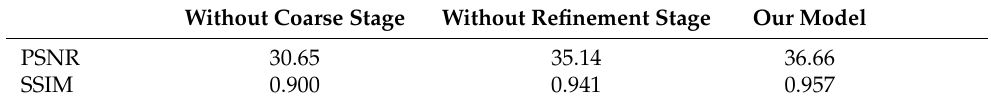
Table 5. Effect of the two stages.